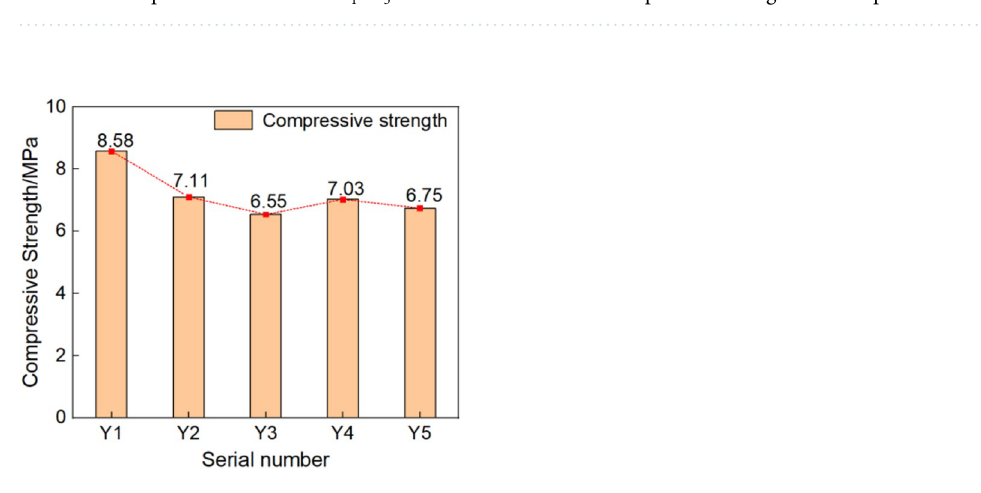
Figure 21. Bar chart of compressive strength of each sample.